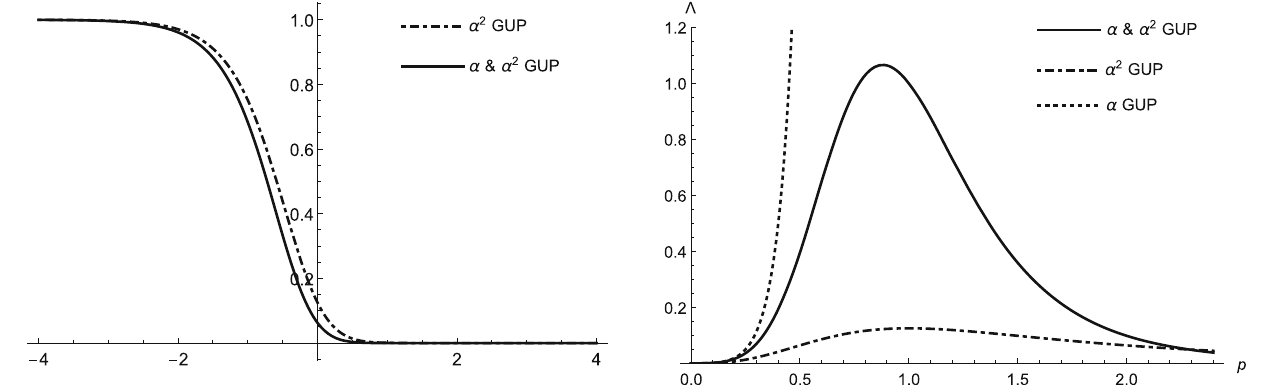
Fig. 2 The effect of different weight factors on the calculations of cosmological constant upon considering LGUP, QGUP and LQGUP when D = 3. We have set α = 1 and m =